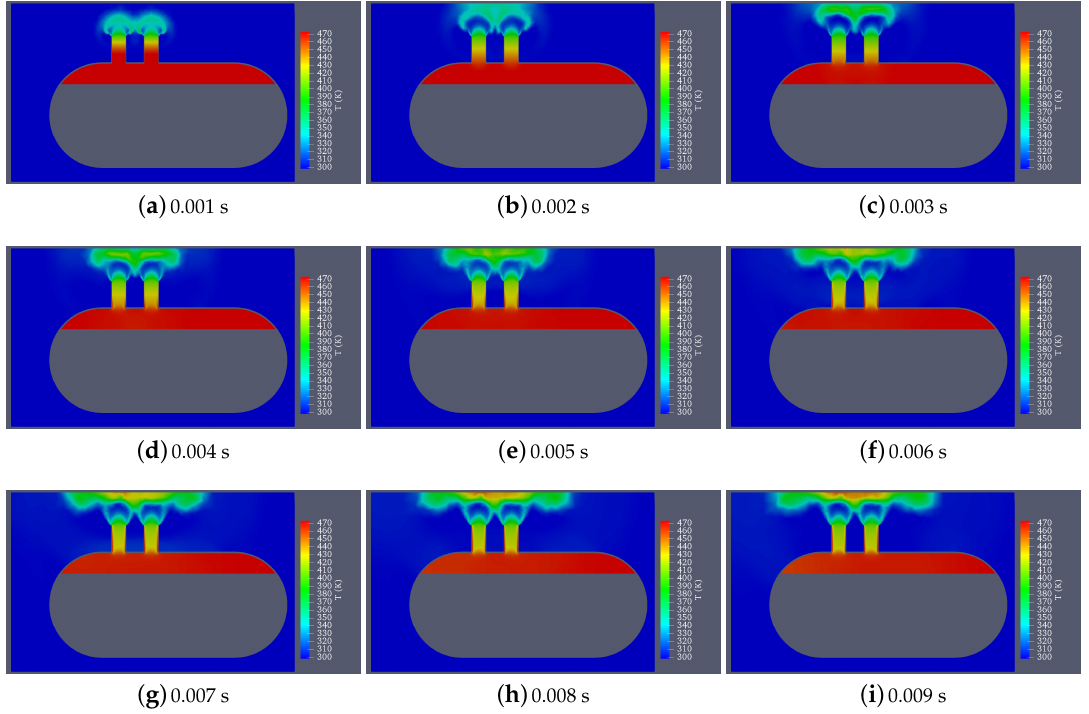
Figure 14. The distribution of temperature of the simulation results of the SST k - ω model by using PRTFOAM at different times from ( a ) 0.001 s to ( i ) 0.009 s with interval ∆ t = 0.001 s (legend unit: